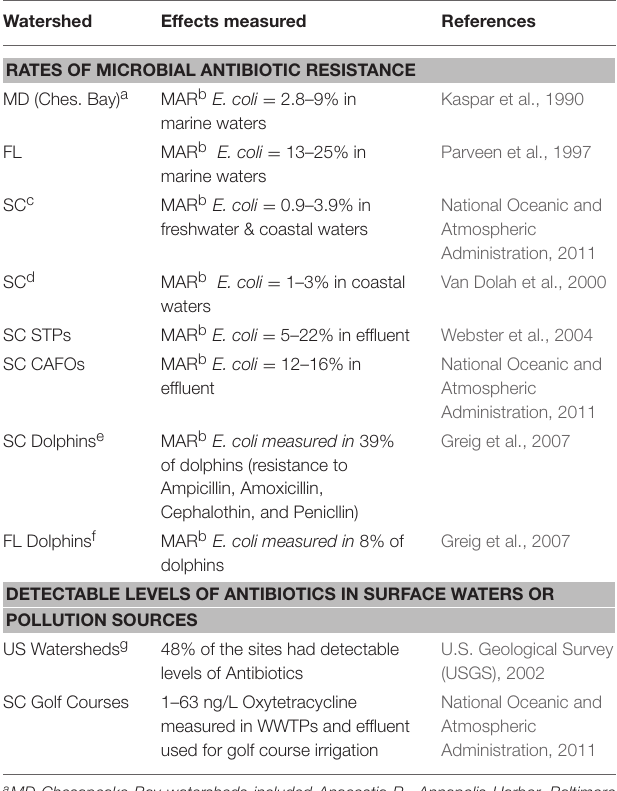
TABLE 4 | Rates of antibiotic resistance in E. coli from selected US